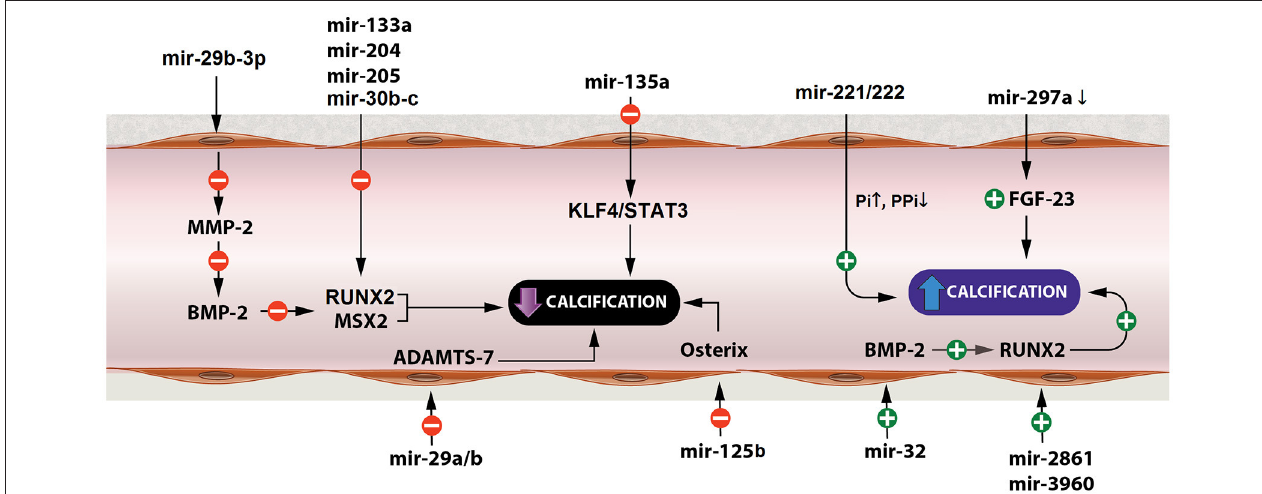
FIGURE 2 | miRNAs affecting arterial calcification. miRNAs play a significant role in arterial calcification by regulating key factors of the calcification process, such as BMP-2, RUNX, ADAMTS-7, osterix, and Pi levels. BMP-2, bone morphogenetic protein-2; RUNX, Runt-related transcription factor 2; ADAMTS-7, disintegrin and metalloproteinase with thrombospondin motifs-7; Pi, inorganic